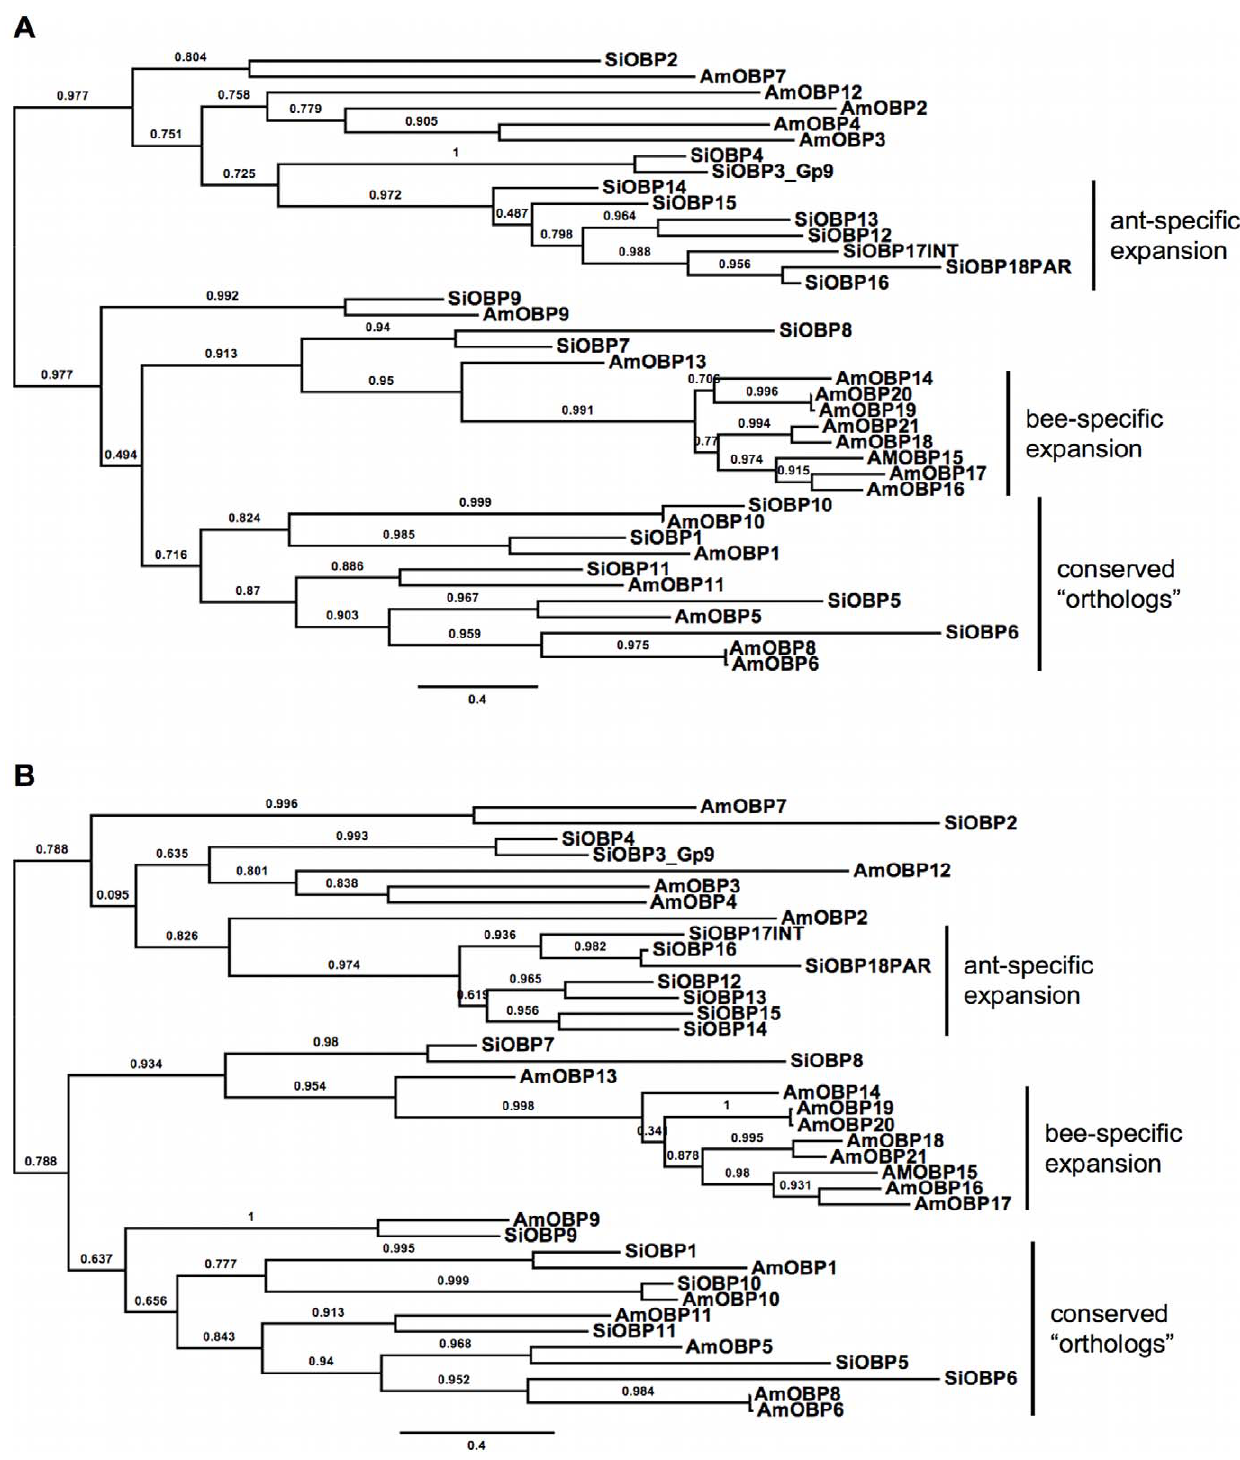
Figure 2. Maximum likelihood phylogenies of the fire ant OBPs (SiOBPs) and honey bee OBPs (AmOBPs). The phylogenies are based on the two best alignments (top: MUSCLE, bottom: PRANK). All trees are midpoint rooted in the absence of a suitable outgroup. Branch support is SH- like aLRT derived from PhyML analyses.